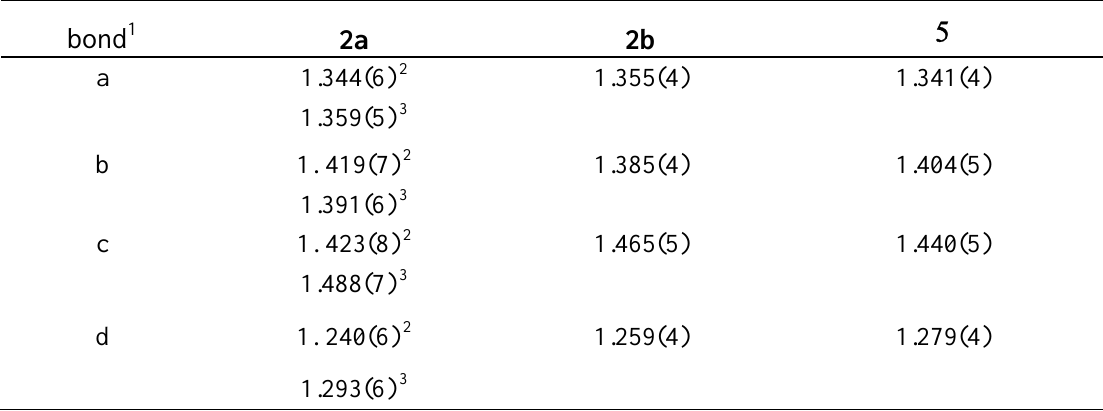
Table 2. Selected bond lengths in the molecules of 2a , 2b and